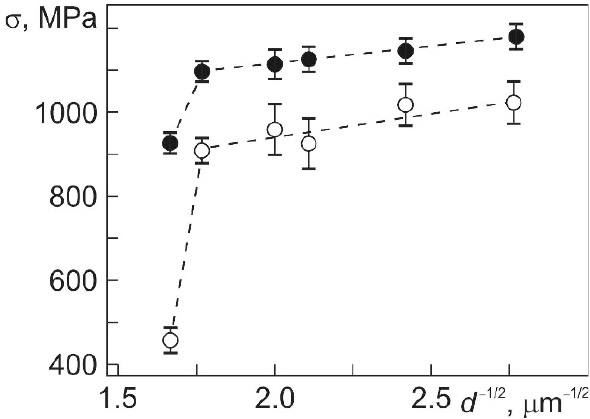
Figure 8. Yield stress, σ y ( ο ), and σ UTS ( ● ), as a function of d − 1/2 .